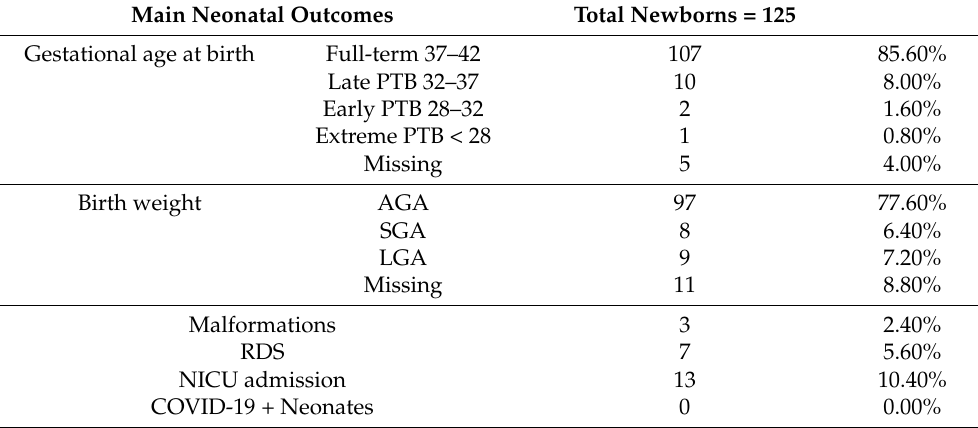
Table 2. Main outcomes of the neonates born from the population under study, including birth weight, malformations, RDS, NICU admission, and neonatal nasopharyngeal PCR swab for COVID- 19 infection (COVID-19 + neonates). In case of complete data for the variable, the relative row of “missing data” is not reported. The abbreviations used in the table are the same as in the manuscript. The percentages considered the missing data, which were not reported for reasons of